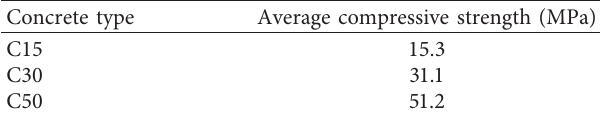
Table 1: The 28-day compressive strength of concrete. Concrete